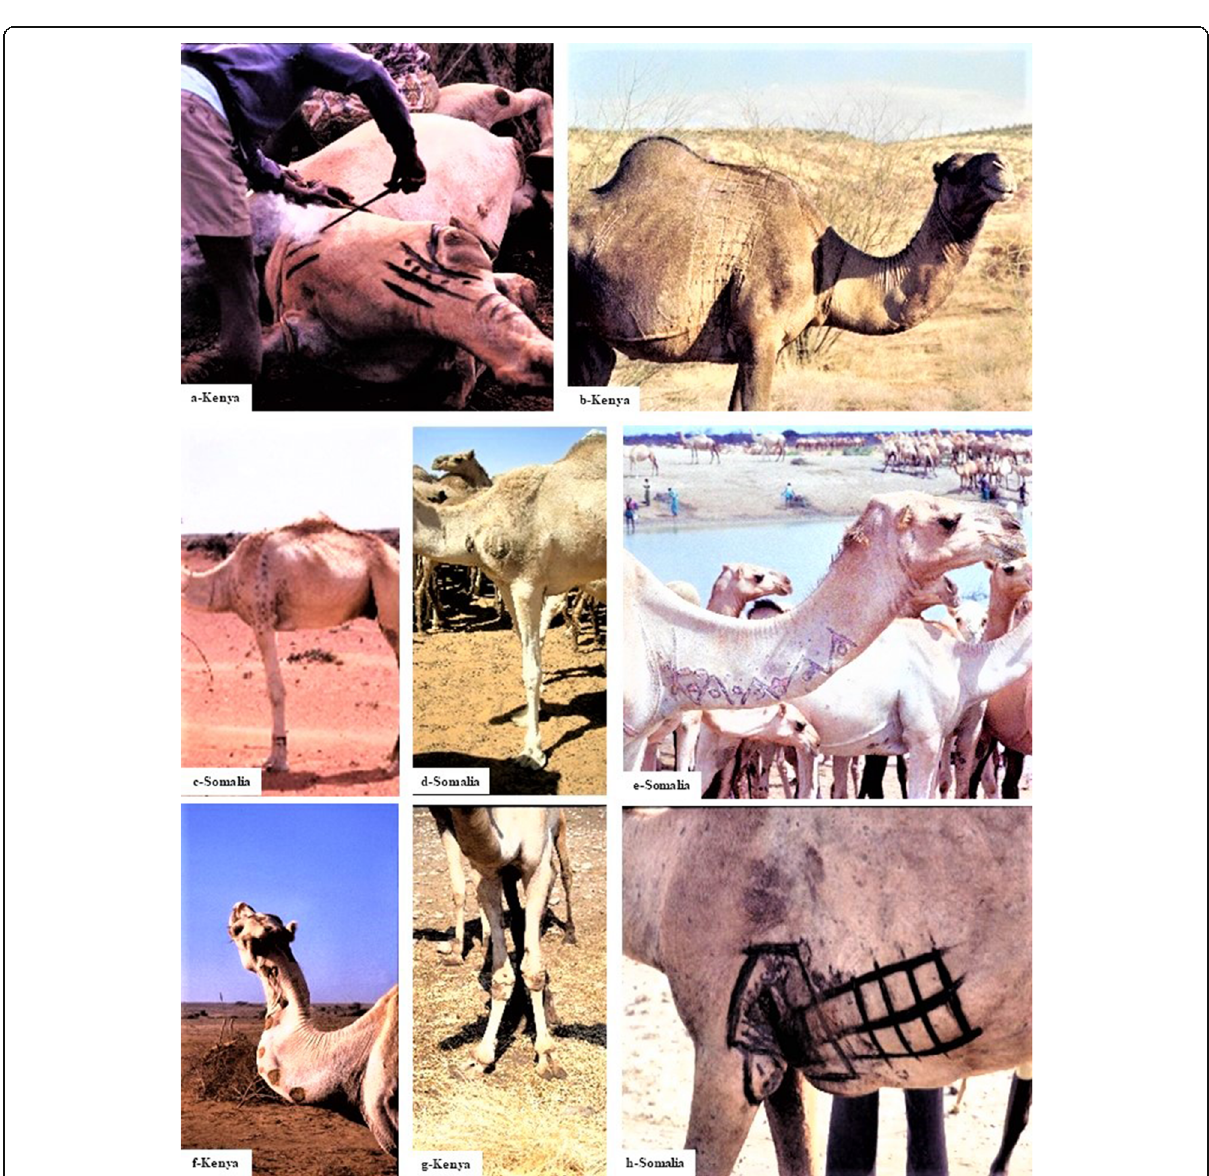
Fig. 12 Images of various ethnoveterinary treatments used by nomadic camel pastoralists in a variety of countries (Dioli 2012,2013, Schwartz and Dioli 1992). a , b , f , g Kenya. c – e , h Somalia. f , g